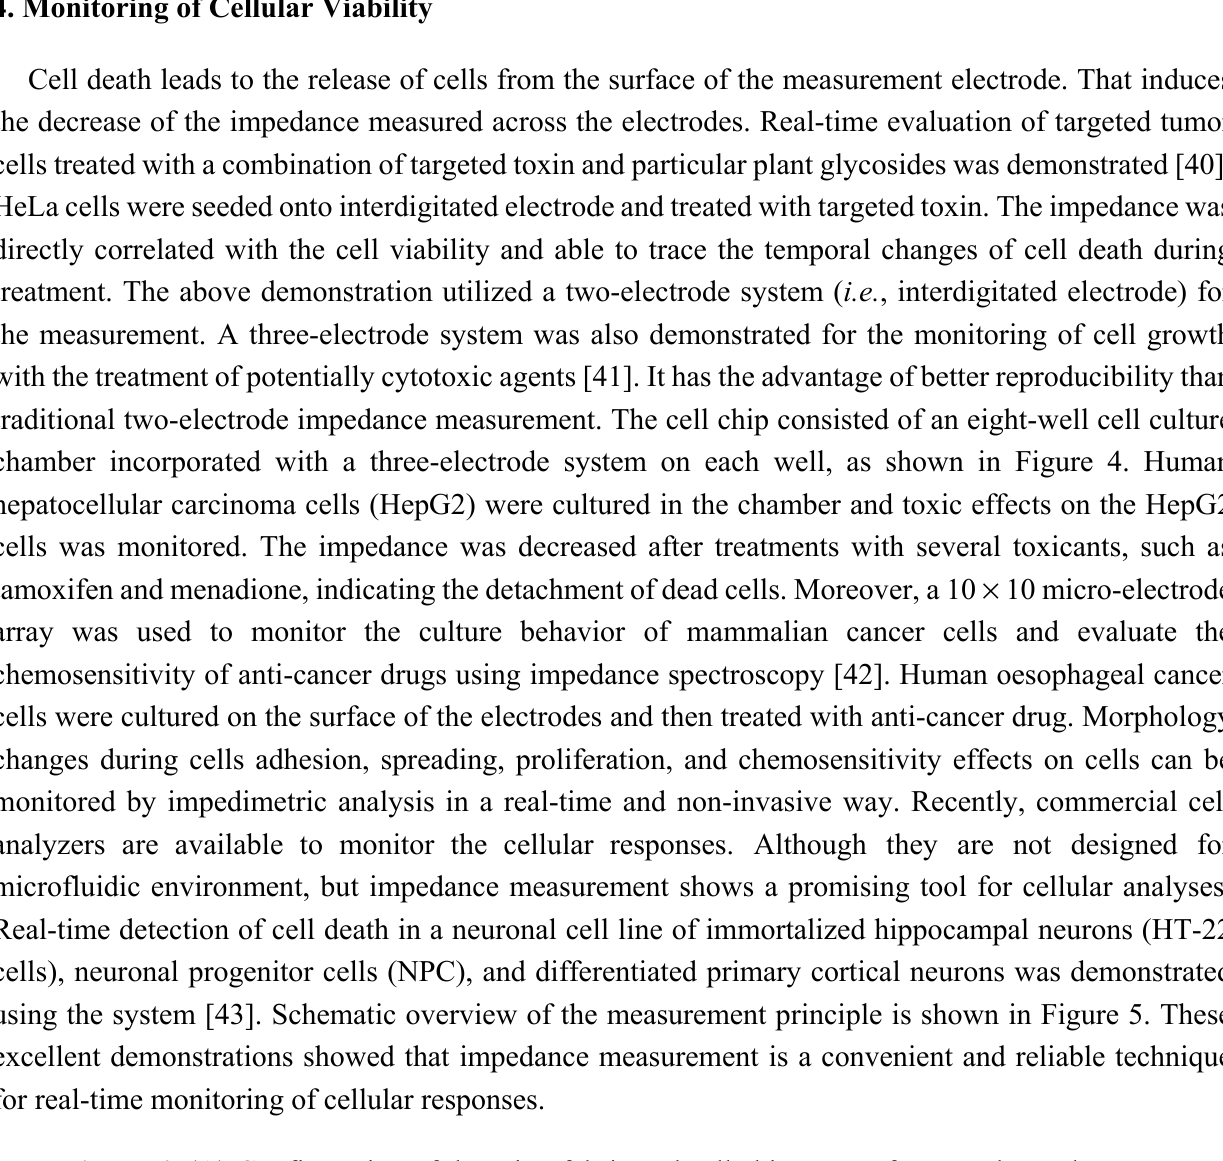
Figure 4. ( A ) Configuration of the microfabricated cell chip: RE, reference electrode; WE, working electrode; CE, counter electrode. ( B ) Fabricated cell chip. (Copyright 2005. Reprinted from [29] with permission from